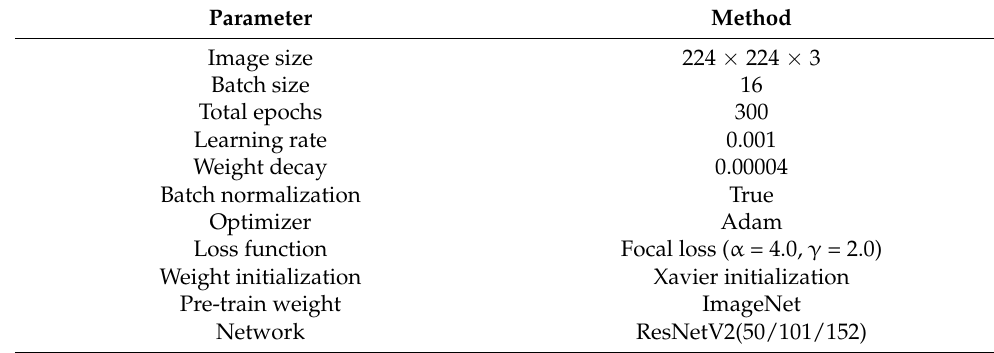
Table 7. The deep residual network training parameters.